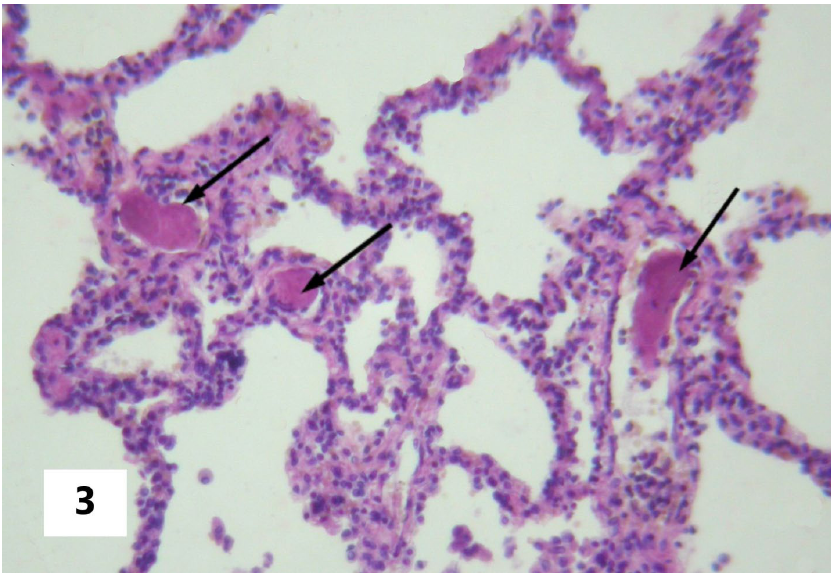
Figure 3. Fibrin clottings of blood in the vessels of the maternal pulmonary microcirculation. The arrows indicate fibrin clottings in pulmonary vessels (Hematoxylin and Eosin stain, ×100 magnification).